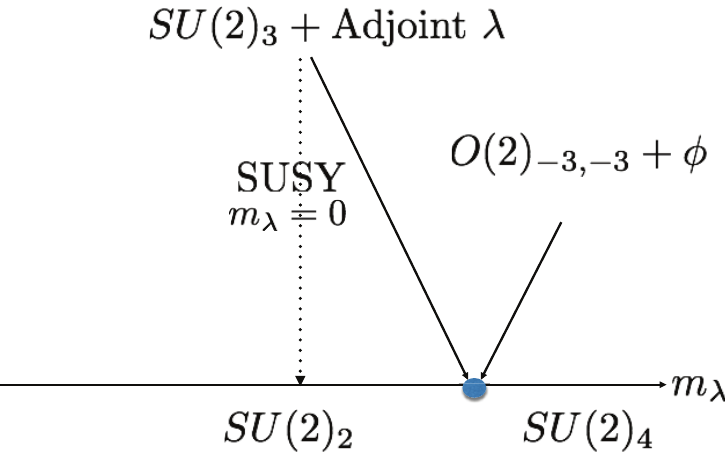
Figure 6: The phase diagram of SU ( 2 ) with an adjoint fermion. We also present a 3 bosonic dual description – a gauged version of the O ( 2 ) Wilson-Fisher